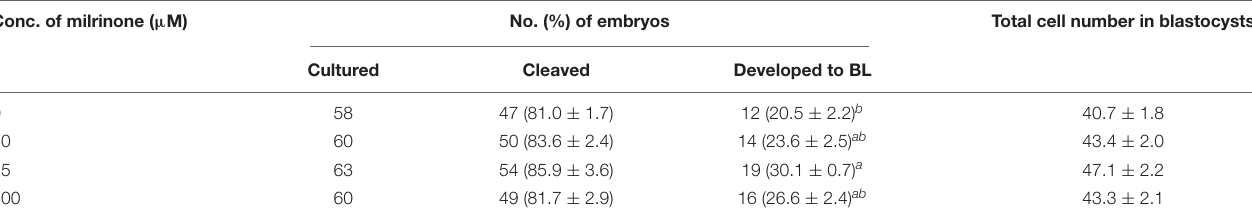
Values in the same column with different superscript letters are significantly different (p < 0.05). Percentages and the total cell number in BL are shown as means ± SEM (n = 6 replicates). BL, blastocyst; COC, cumulus–oocyte